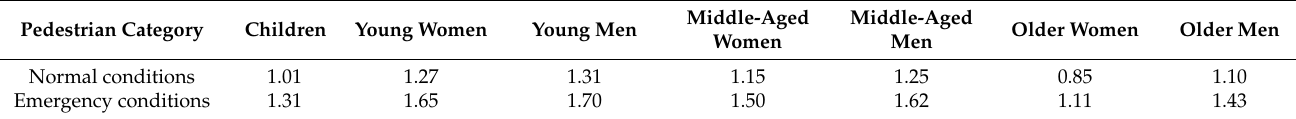
Table 7. Walking speed of different groups (m/s).